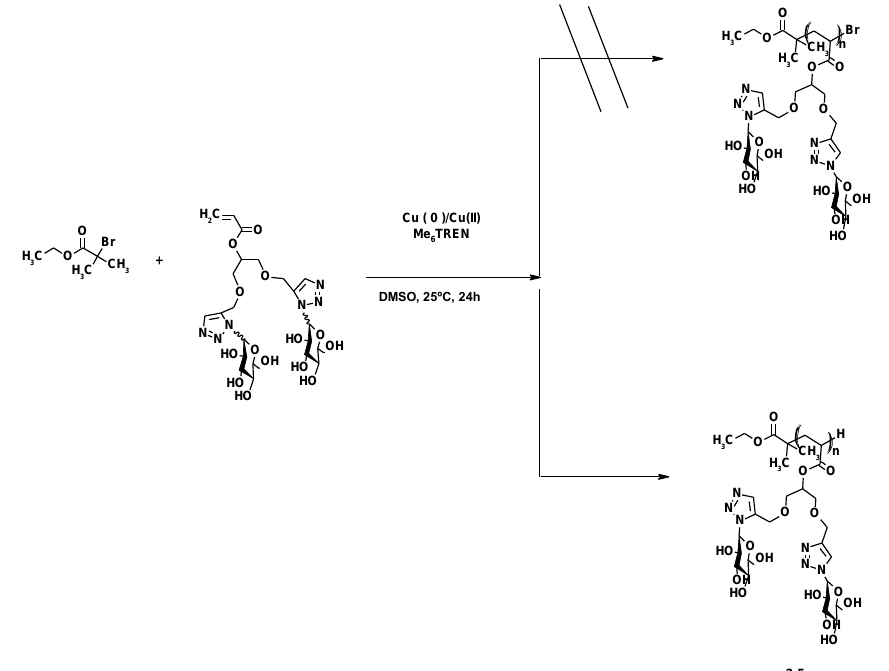
Figure 27. Proposed structure for the dead polymer synthesized through SET-LRP polymerization.